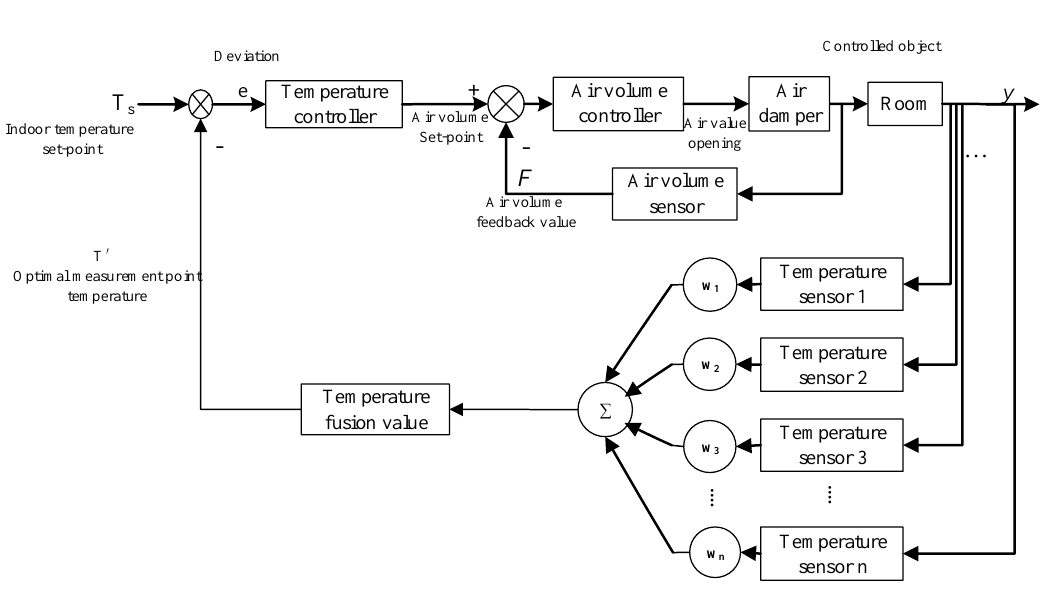
Figure 19. Multisensor indoor temperature control block diagram.